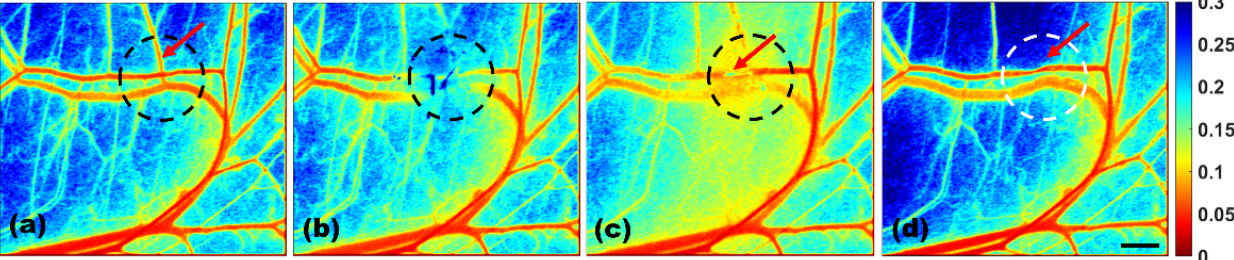
Figure 9. Real-time monitoring of blood flow and thrombus formation by using the ADF algorithm (scale bar = 100 µm). ( a ) Before irradiation, ( b ) during irradiation, ( c ) thrombosis formation, ( d ) after irradiation.